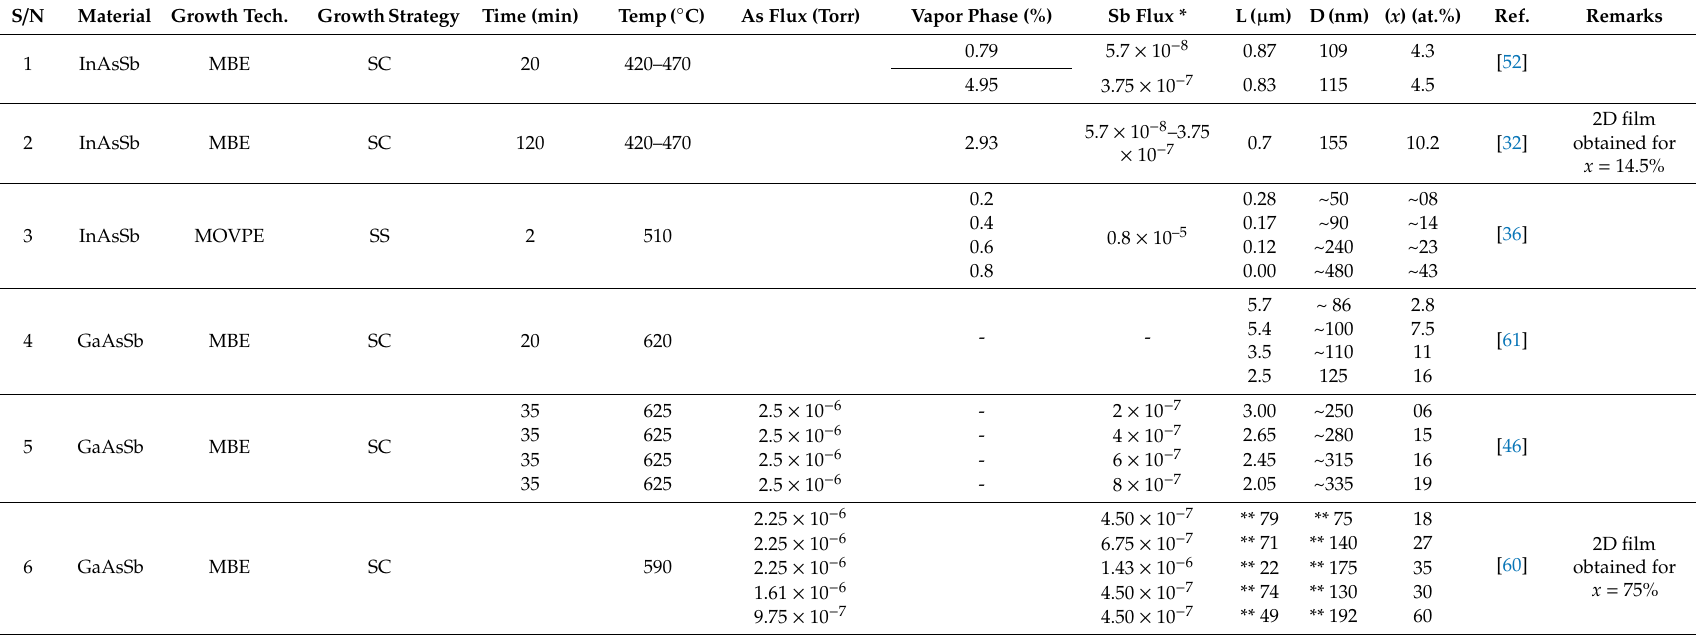
Table 1. Influence of Sb composition ( x ) on III–As–Sb Nanowires